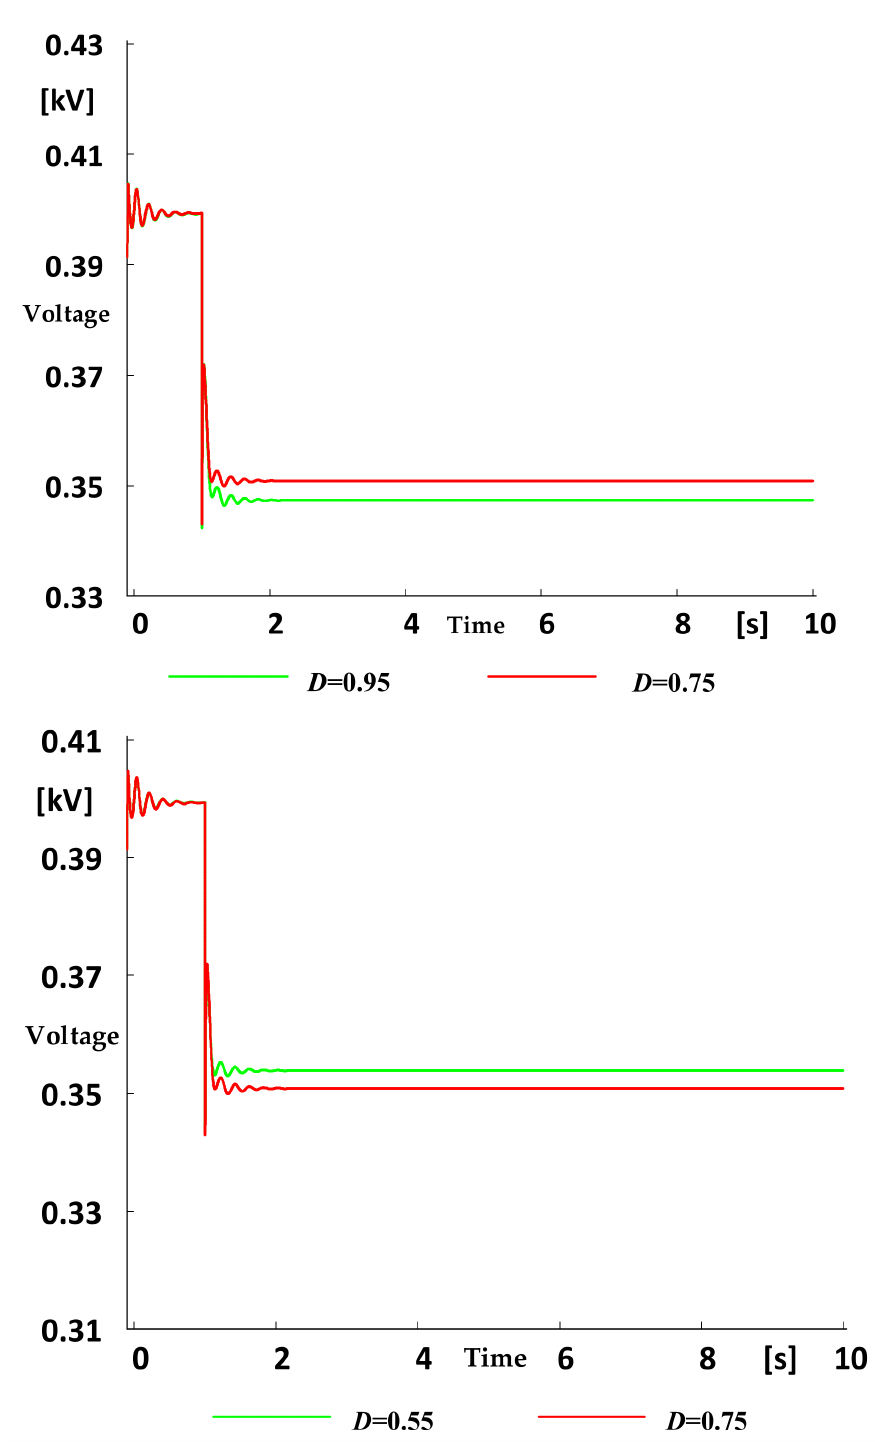
Figure 12. DC bus voltage waveform with different